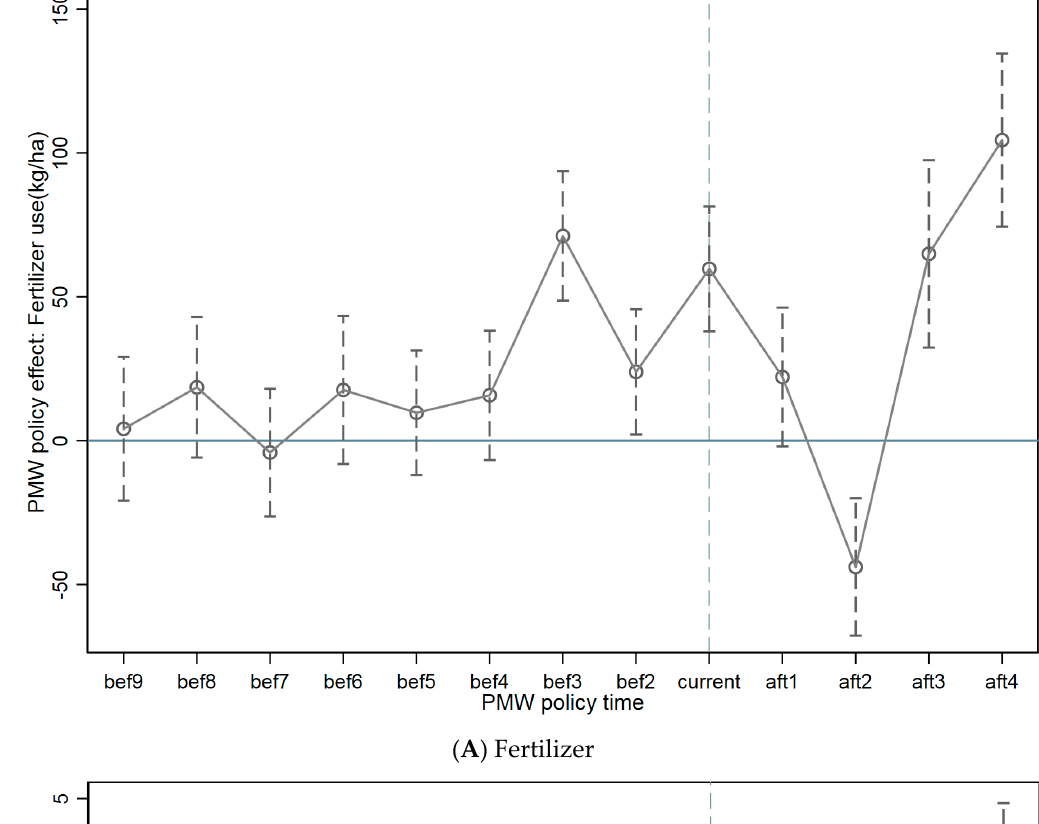
Figure A1. Trends of average price for ( A ) Wheat and ( B ) Rice; In yuan/kg; All prices have been deflated to 1997 prices, using national consumer price index data. Source: Calculated from the RFOP survey data set 1997–2010 combined with [3].